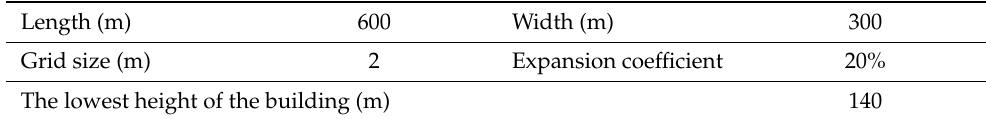
Table 2. The parameters of the ENVI-met model.